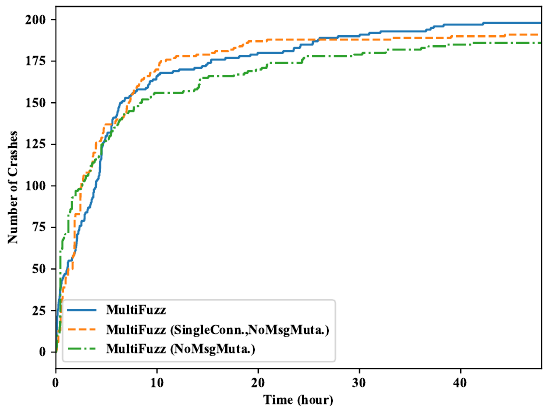
Figure 10. Crashes found in libCoAP by MultiFuzz and its variations.